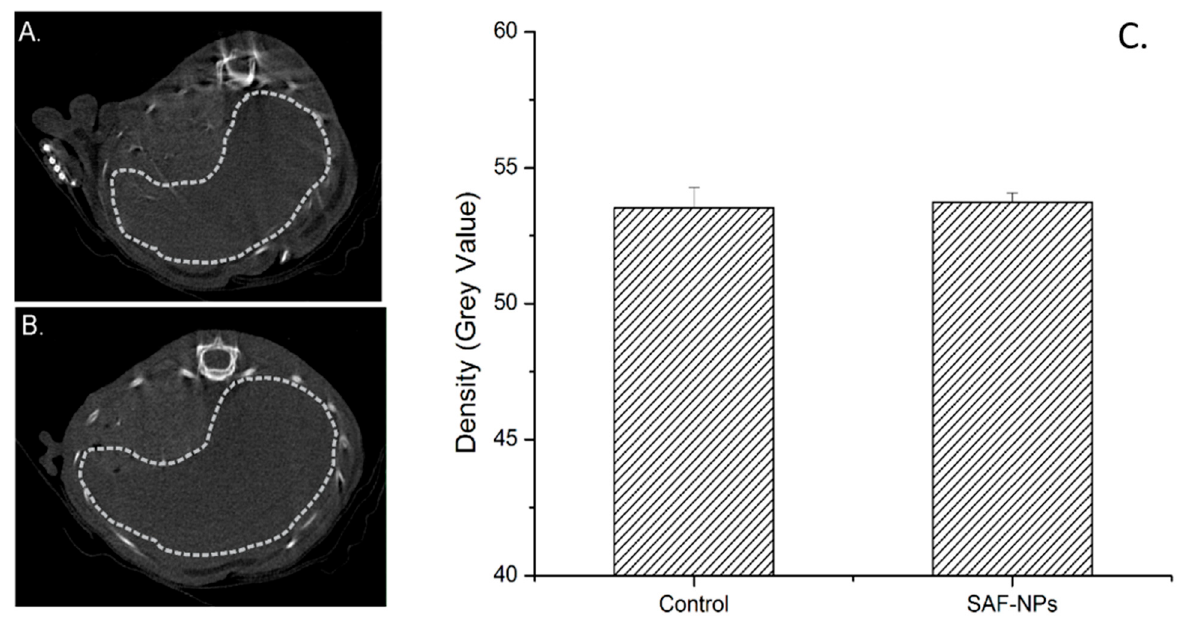
Figure 5. Transversal liver CT images of a control mouse ( A ) and after intravenous SAF-NP injection ( B ). ( C ) The dotted grey line indicates the region of interest (ROI) of the liver. No significant contrast enhancement could be observed after SAF-NP injection, as shown by the significant density of the SAF-NP-injected liver compared to the control. Ex vivo dark-field imaging of the liver and spleen confirmed the presence of SAF-NPs whereas the heart (control) and kidney tissue did not show any particle retention (Figure